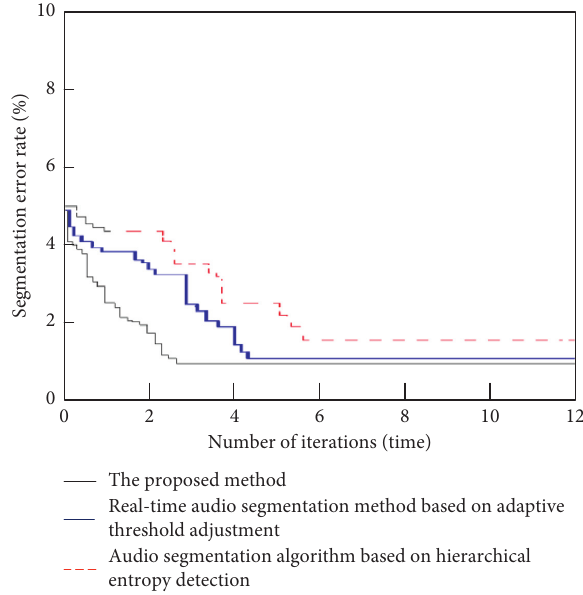
Figure 3: Comparison of music segmentation error rate. Table 2: Comparison of recall and precision